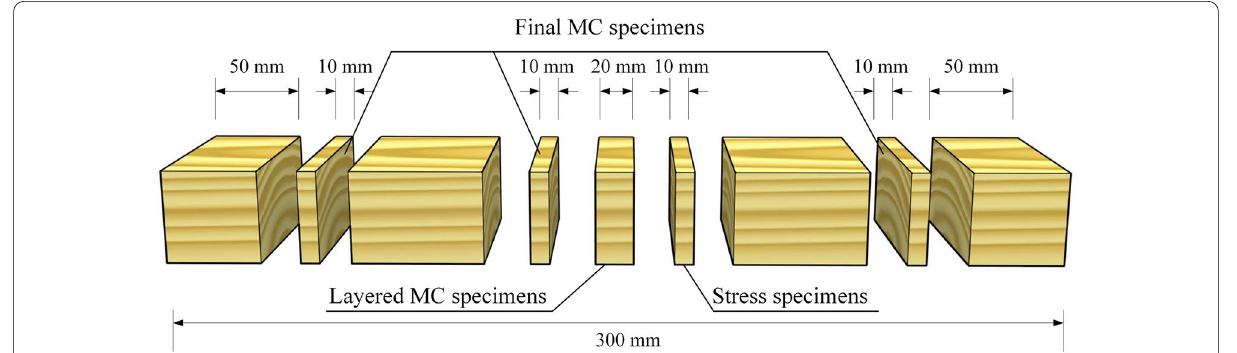
Fig. 2 Cutting of test pieces for measuring drying